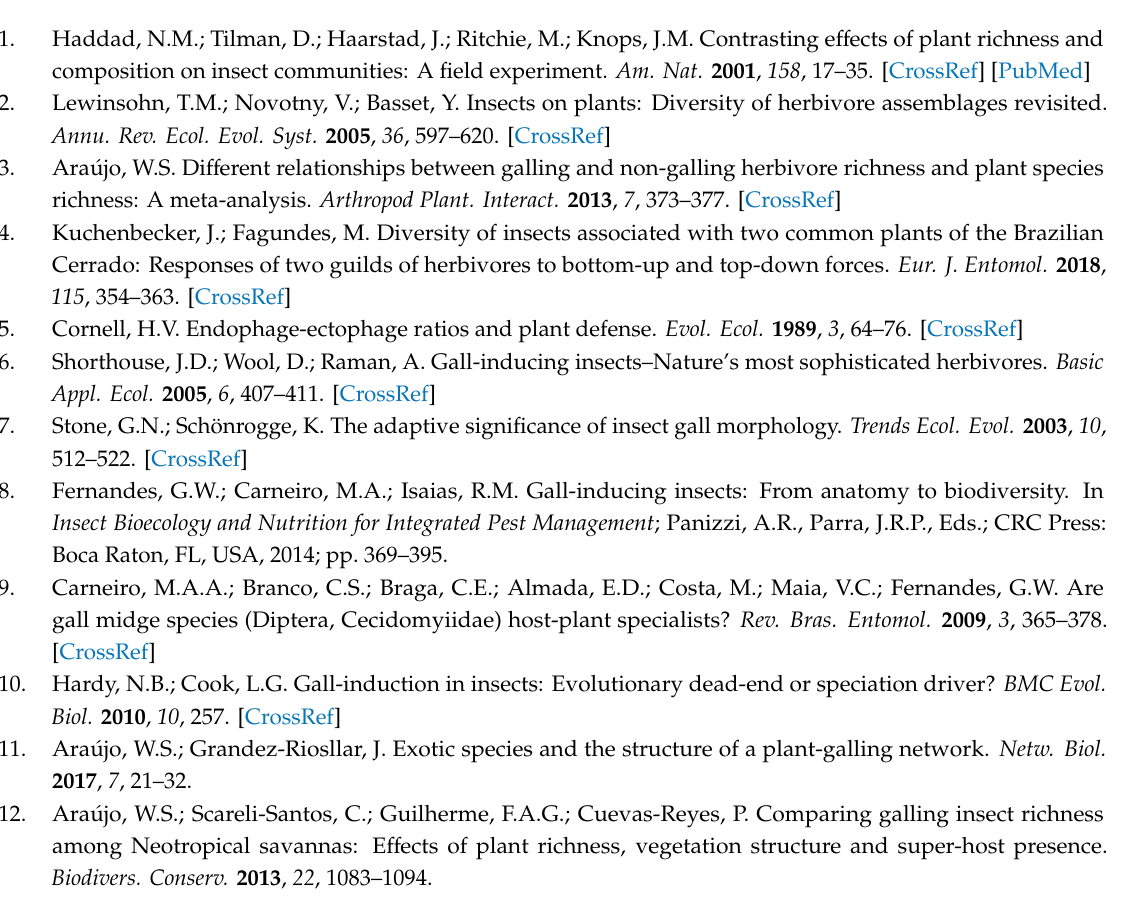
Table S1: Checklist of galling insect species and host plant species recorded in the